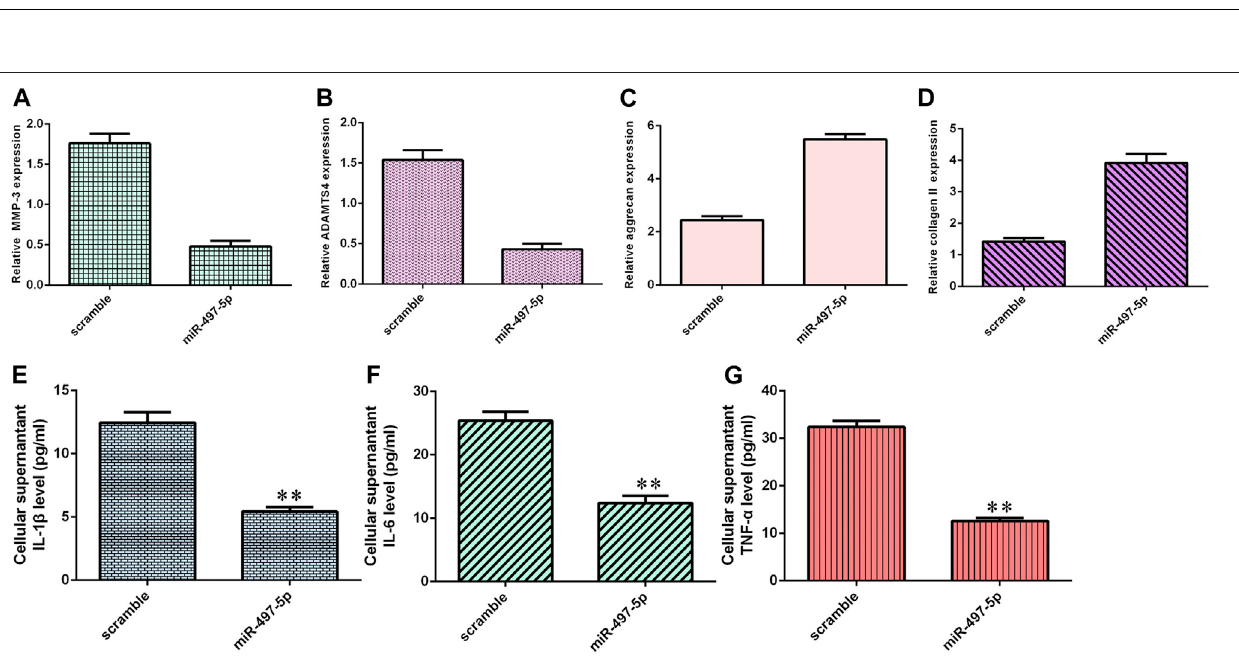
FIGURE 6 | miR-497-5p suppressed in fl ammatory cytokine expression and ECM degeneration. (A) MMP-3 expression was detected by qRT-PCR. (B) Overexpression of miR-497-5p suppressed ADAMTS4 expression in NP cells. (C) Aggrecan expression was measured by qRT-PCR. (D) Collagen II expression was detected by qRT-PCR. (E) IL-1 β expression was determined by ELISA. (F) IL-6 expression was determined by ELISA. (G) TNF- α expression was determined by ELISA. ** p < 0.01.